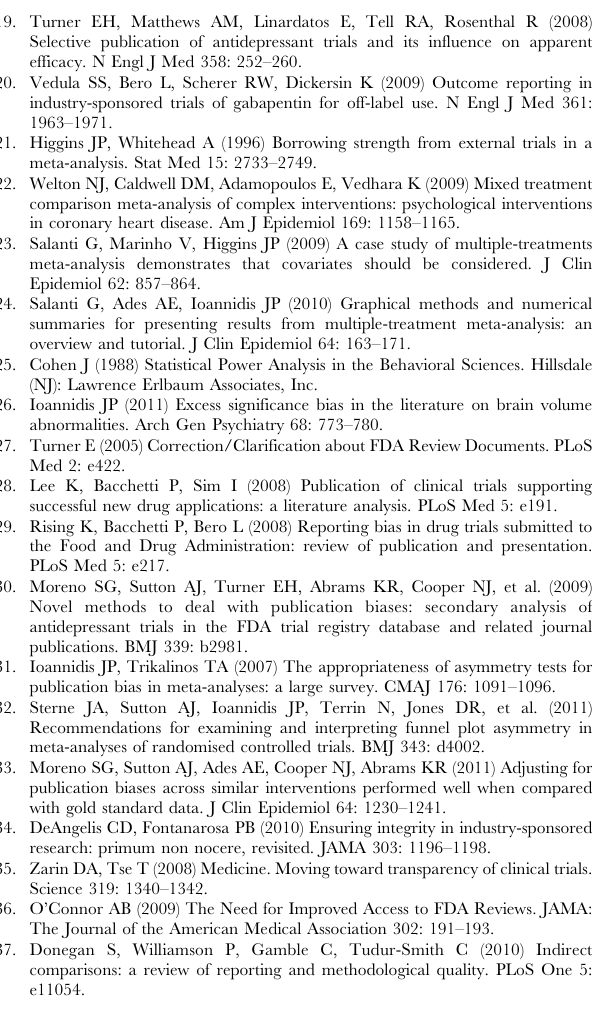
Figure S2 Rankograms for the 12 antidepressant agents. Figure S3 Cumulative ranking probability plots for the 12 antidepressant agents. Figure S4 Surface under the cumulative ranking line for the 12 antidepressant agents. Figure S5 Rankings for the 12 antidepressant agents. Table S1 Effect sizes and probabilities of superiority from network